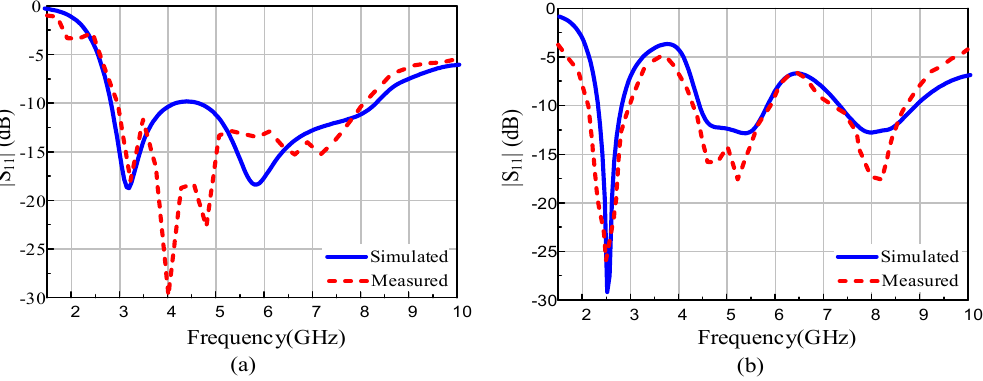
Figure 7. Simulated and measured |S 11 |: ( a ) diode ON and ( b ) diode OFF.